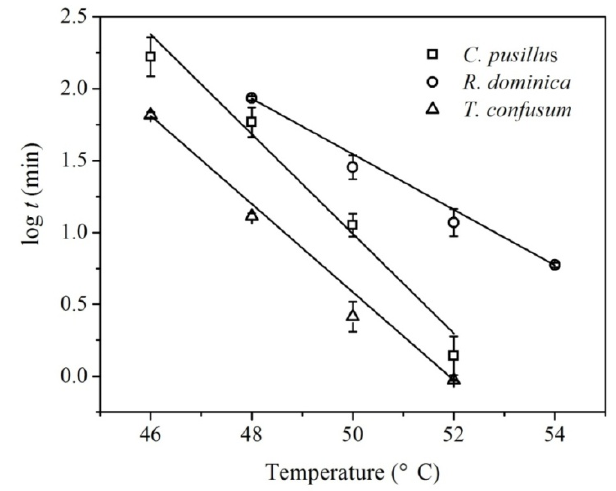
Figure 3. Thermal mortality curve for adult C. pusillus, R. dominica, and T. confusum at heating rate of 5 °C/min.